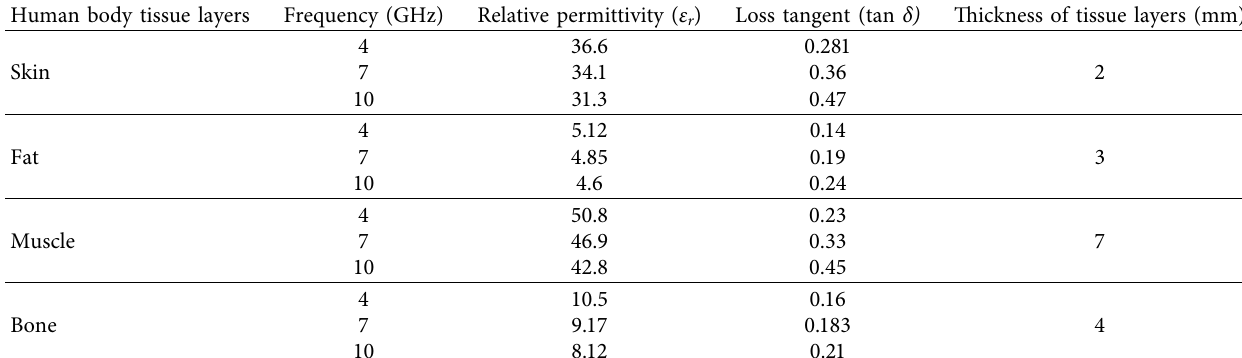
Figure 19: SAR analysis of the MIMO antenna: (a) rectangular human body model and (b) SAR values. Table 1: Tissue properties of human